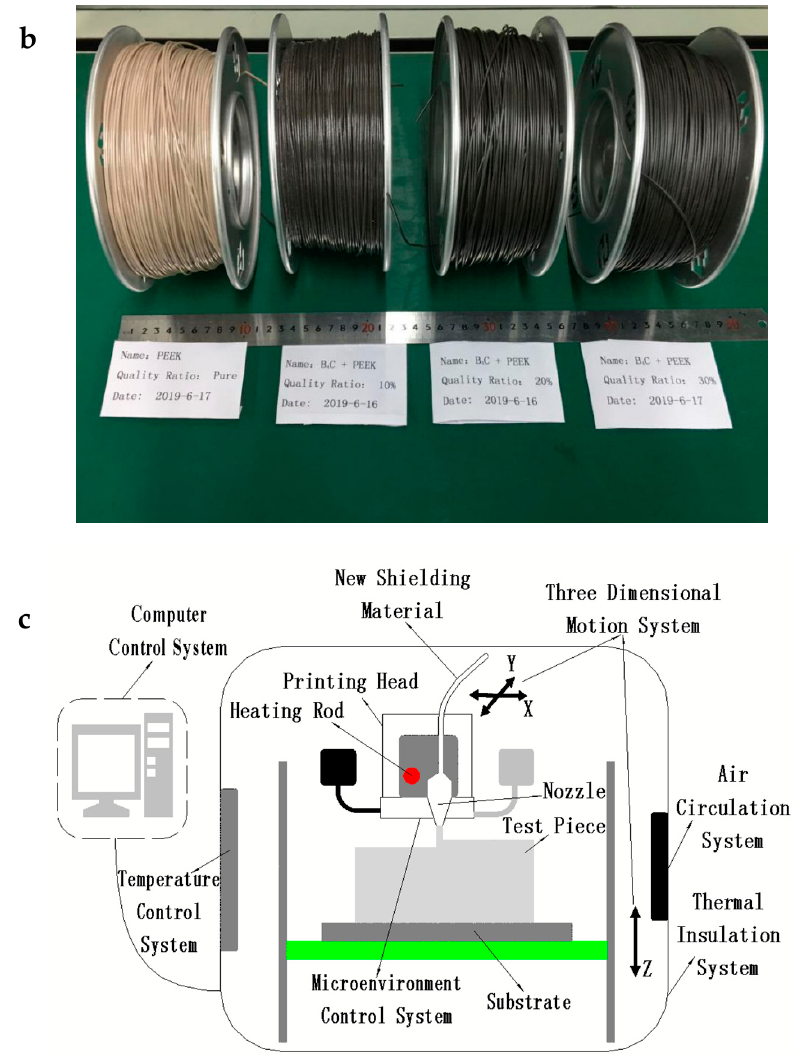
Figure 1. ( a ) Preparation of new shielding materials, ( b ) fused deposition modeling (FDM) special material of boron carbide polyether-ether-ketone (PEEK) composites, and ( c ) FDM processing flow diagram.